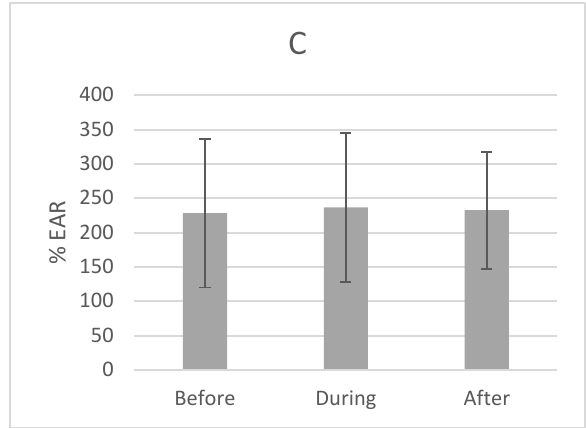
Before During After Figure 3. Percentage of estimated average requirement of vitamin intake in the three stages of the study. All vitamins are ingested in less quantity after starting treatment. Despite the results, only statistically significant changes were observed in the intake of vitamins B 2 ( p = 0.006), Table 3 shows the percentages of intake below the EAR, of each of the vitamins studied in each of the moments of the study. We can observe that the consumption of vitamins is lower than the EAR with greater frequency during and/or after the treatment, with the exception of vitamin C, where its consumption increases during and after the treatment. We found statistically significant decreases, when comparing the three periods, in the intake of